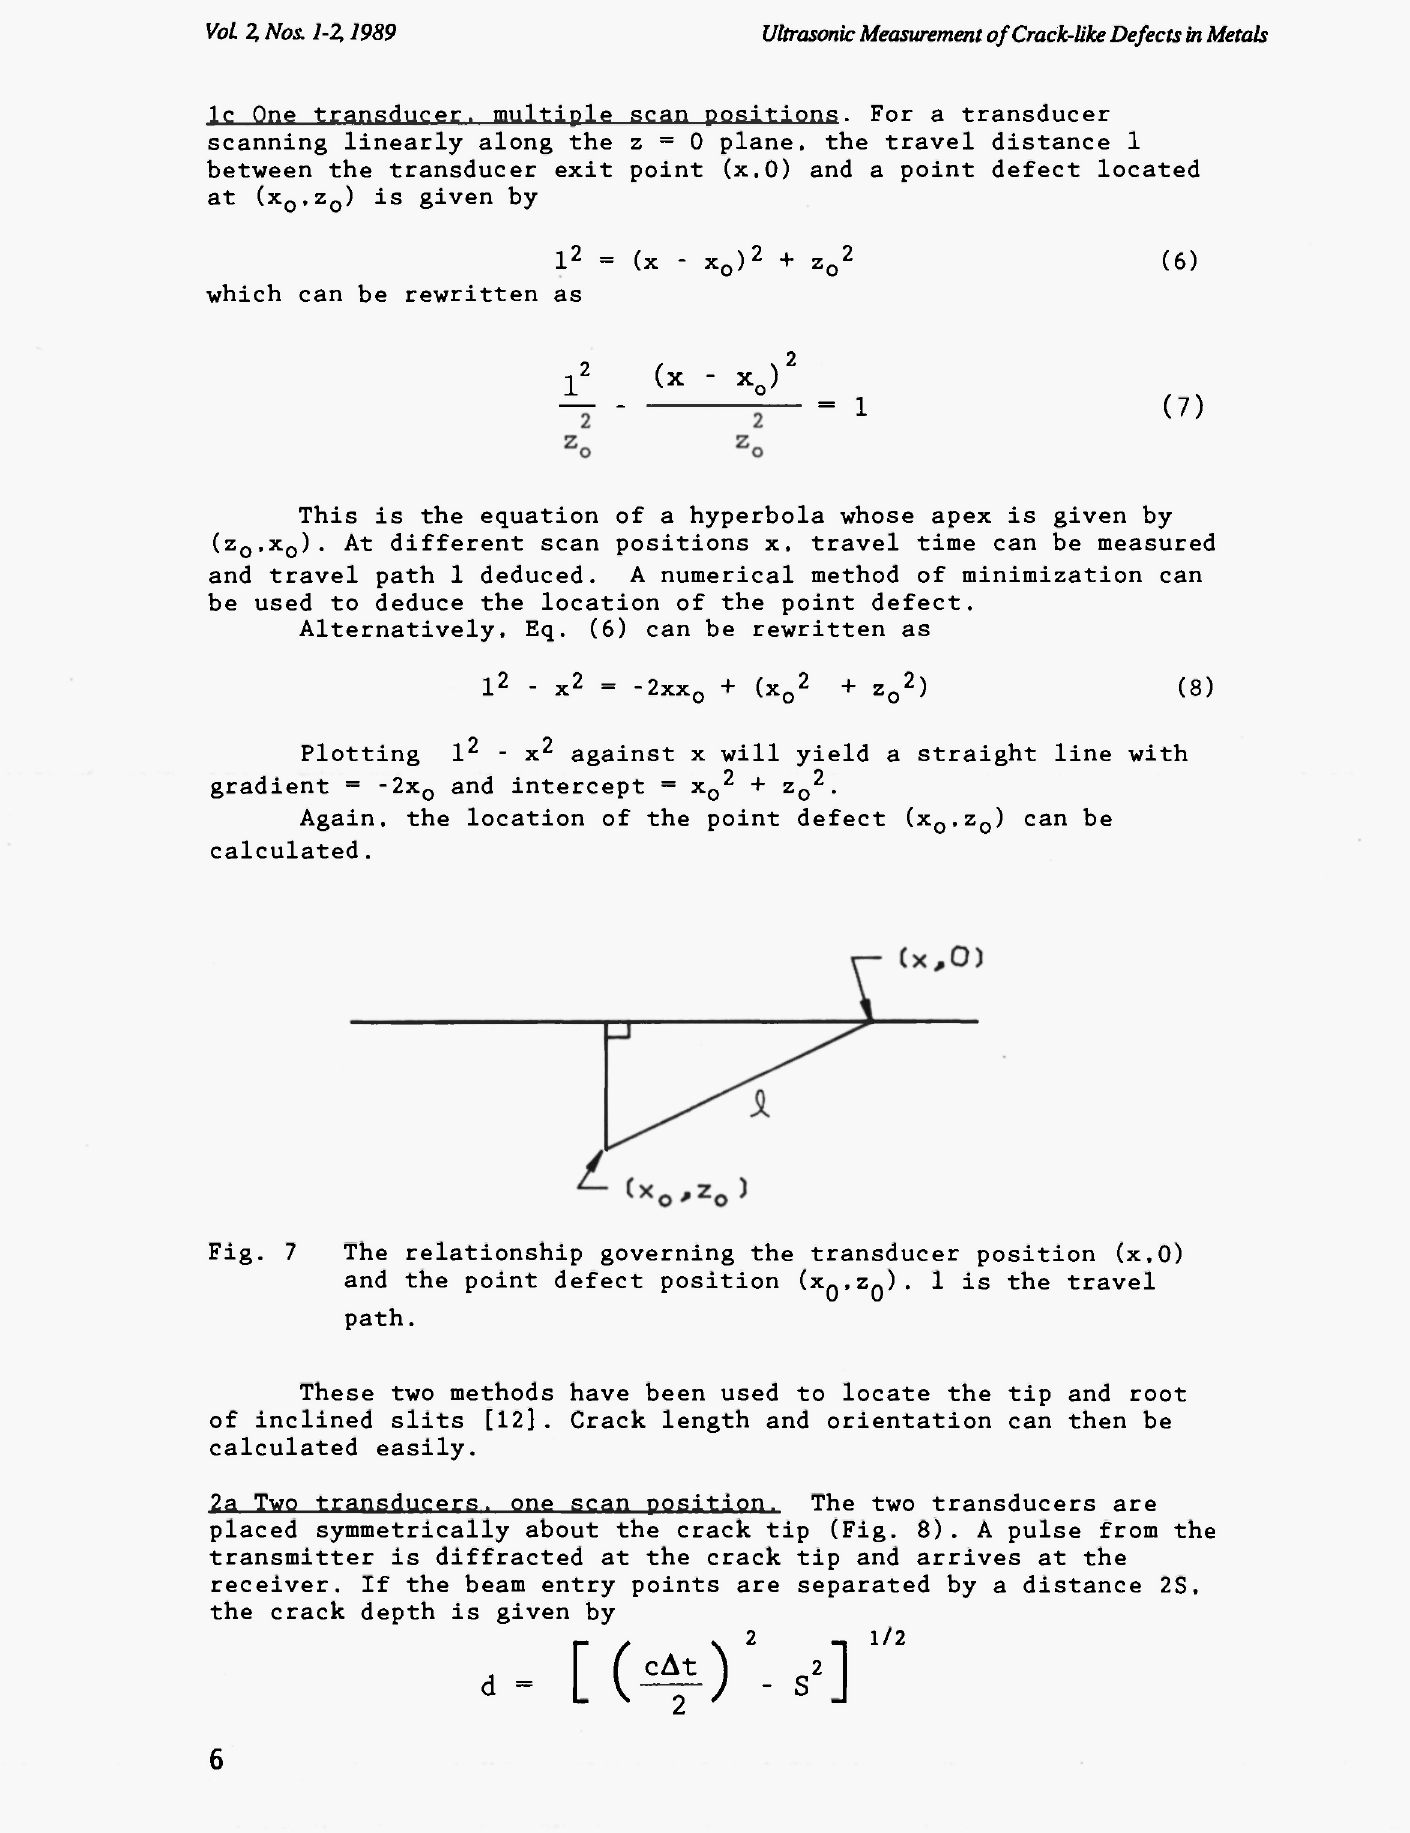
Fig. 7 The relationship governing the transducer position (x.O) and the point defect position ( XQ . ZQ ). 1 is the travel